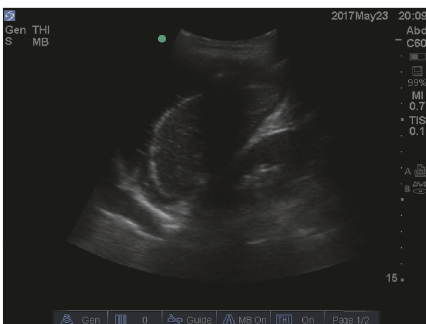
Figure 4: CT abdomen image demonstrating free fluid to the right upper quadrant and free